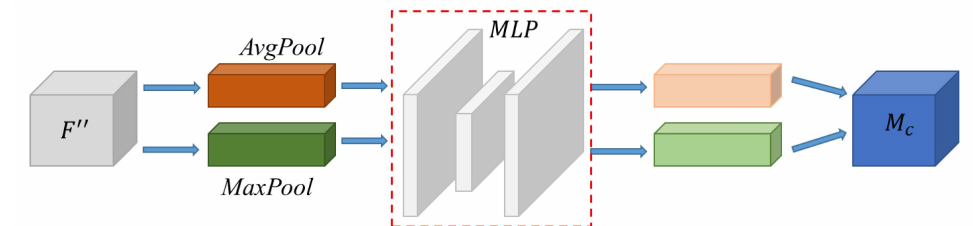
Figure 9. Channel attention module.